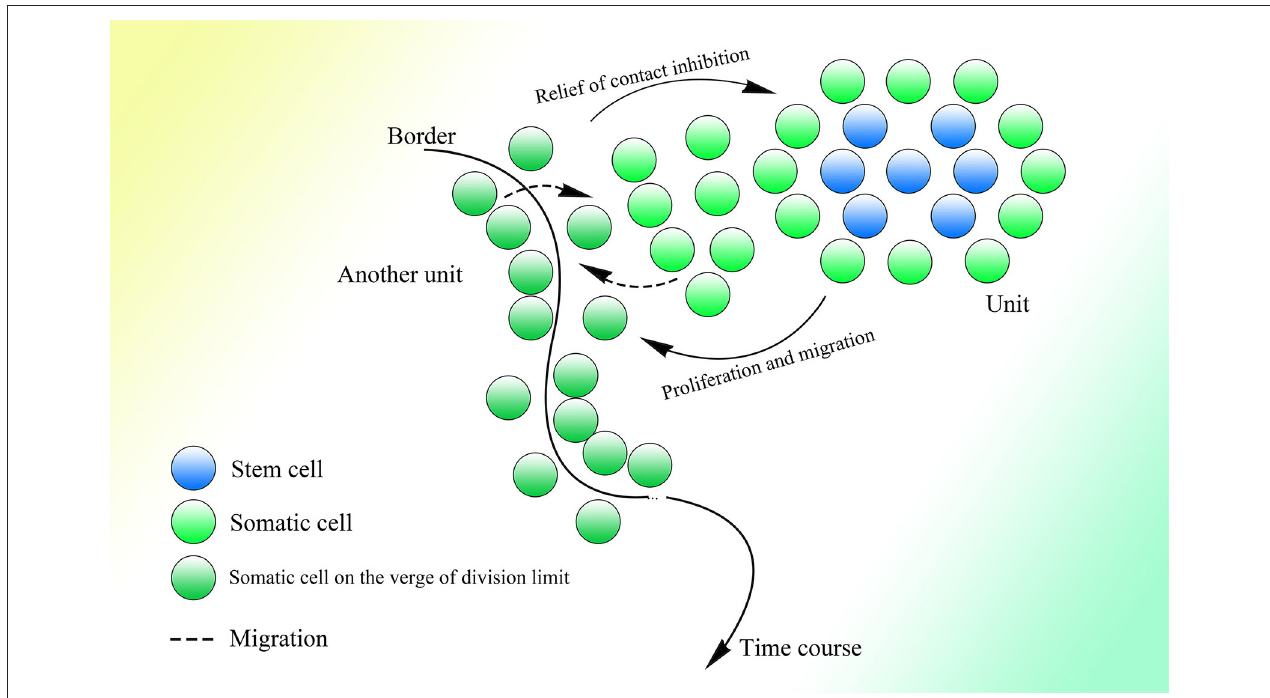
FIGURE 10 | A possible pattern in which cell proliferation could be strictly regulated. According to tumor stem cells and their proliferation pattern, tissue could be divided into lots of units that would consist of stem cells and somatic cells. The central stem cells would be surrounded by other stem cells, and they would not differentiate and could only divide into stem cells; the stem cells near the somatic cells would receive stimulation from stem cells and gradually differentiate to somatic cells. The proliferation of cells at the border between the two units might fluctuate. When the cell density of one side decreases, the cells below the border and those on the other side of the border will migrate toward it, resulting in increased cell density on this side of the border and decreased cell density on the other side of the border and thus stimulating the cells below the border of the same side and on the other side of the border to proliferate. As the cells on the other side of the border are on the verge of the division limit, further division will lead to apoptosis and decreased cell density. This cycle will ensure that all cells divide periodically.